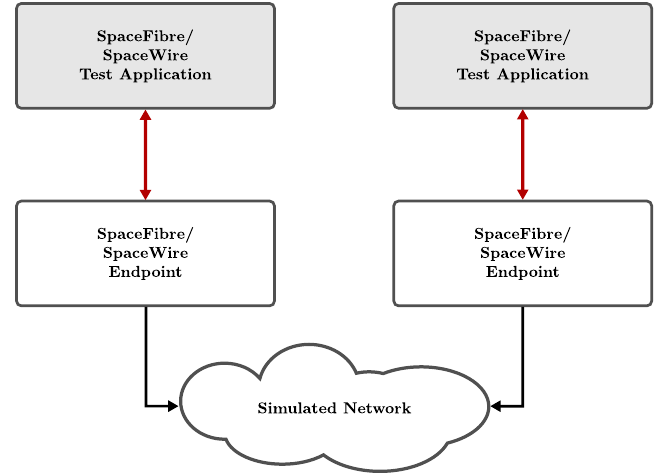
Figure 5. SpaceFibre and SpaceWire Test